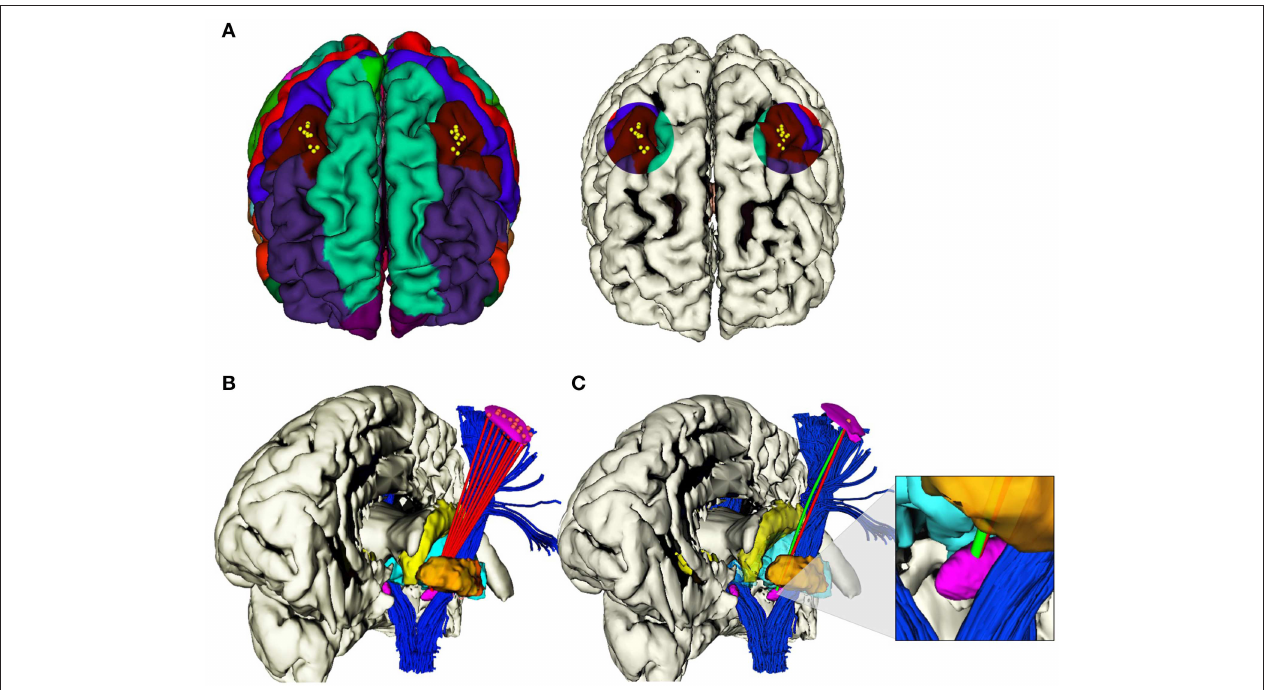
FIGURE 2 | (A) Selected areas of 1 cm diameter in the caudal middle frontal gyrus, where i ∈ 1,..,10 EP i were determined in each hemisphere. (B) Example of the computation of i viable RTs (red) from i EPs to the same TP on the anterior portion of STN, left hemisphere. (C) Example of the computation of correspondent RT (red) and CT (green), from the same EP i to the same TP i on the anterior portion of STN, left hemisphere.